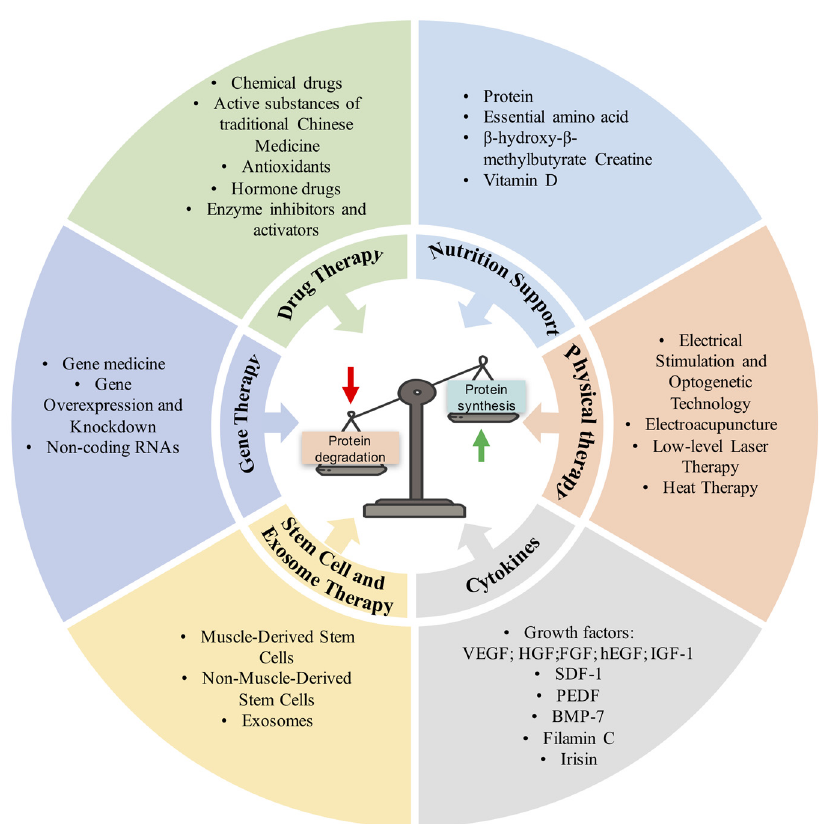
Figure 3. The current potential therapeutic strategy for skeletal muscle atrophy. VEGF, vascular endothelial growth factor; HGF, hepatocyte growth factor; FGF, fibroblast growth factor; hEGF, human epidermal growth factor; IGF-1, insulin-like growth factor 1; SDF-1, stromal cell-derived factor-1; PEDF, pigment epithelium-derived factor; BMP, bone morphogenetic protein-7.